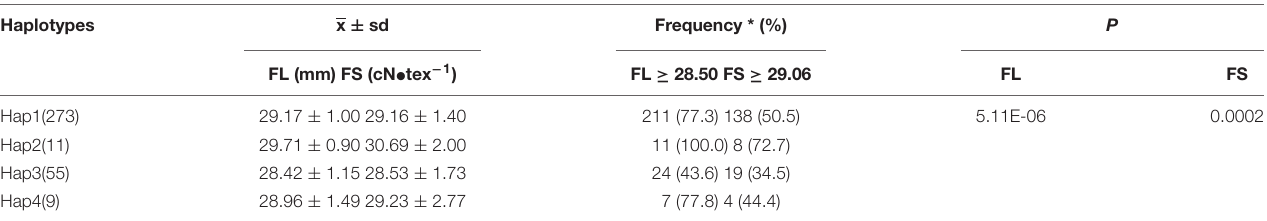
TABLE 4 | The effects and frequencies of different haplotypes on FL and FS in the population of 360 accessions. Haplotypes